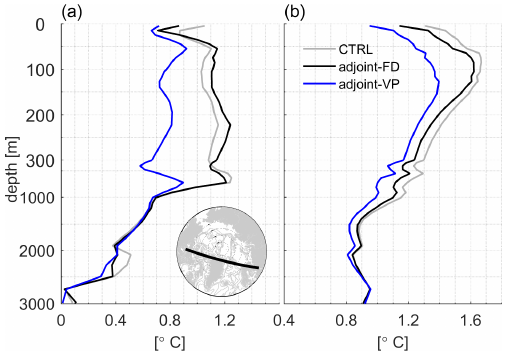
Figure 6. RMSEs of potential temperature in the (a) Arctic Ocean and (b) North Atlantic Ocean in the three runs. The Arctic Ocean and the North Atlantic Ocean are separated by the black lines in the bottom